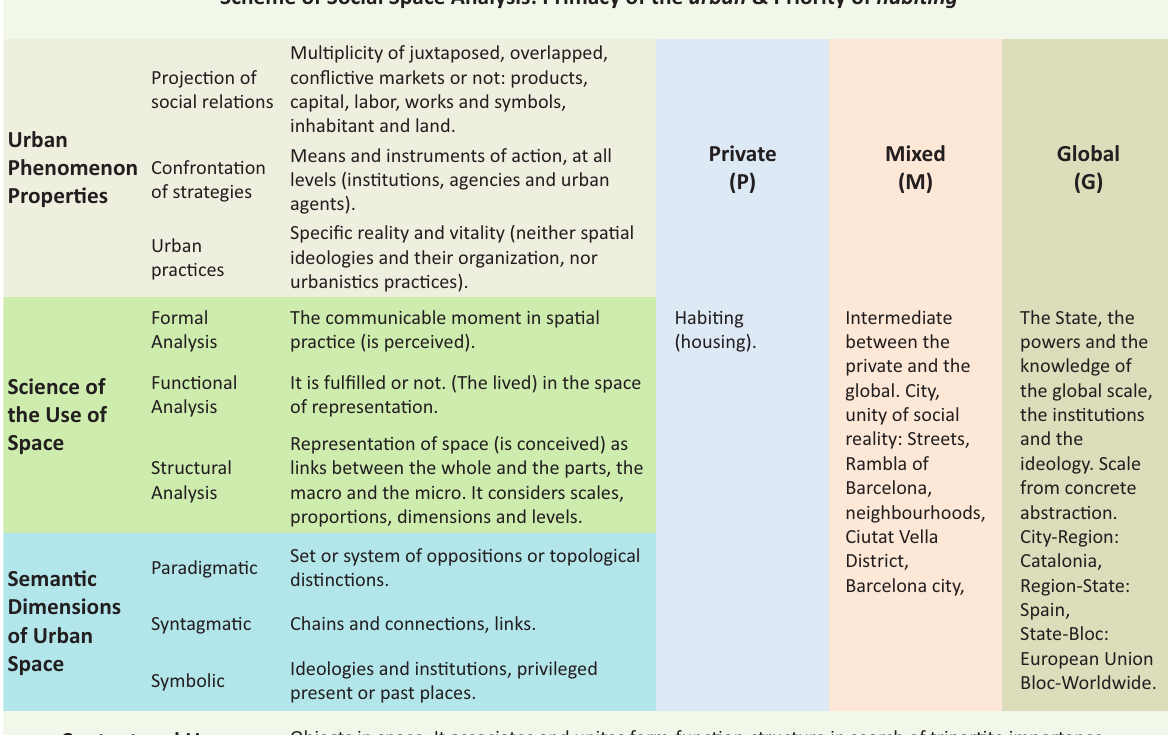
Figure 3. Summary assembled grid for the Lefebvrian social space analysis. To see grid unfolded refer to Appendix 5. Source: Jiménez Pacheco